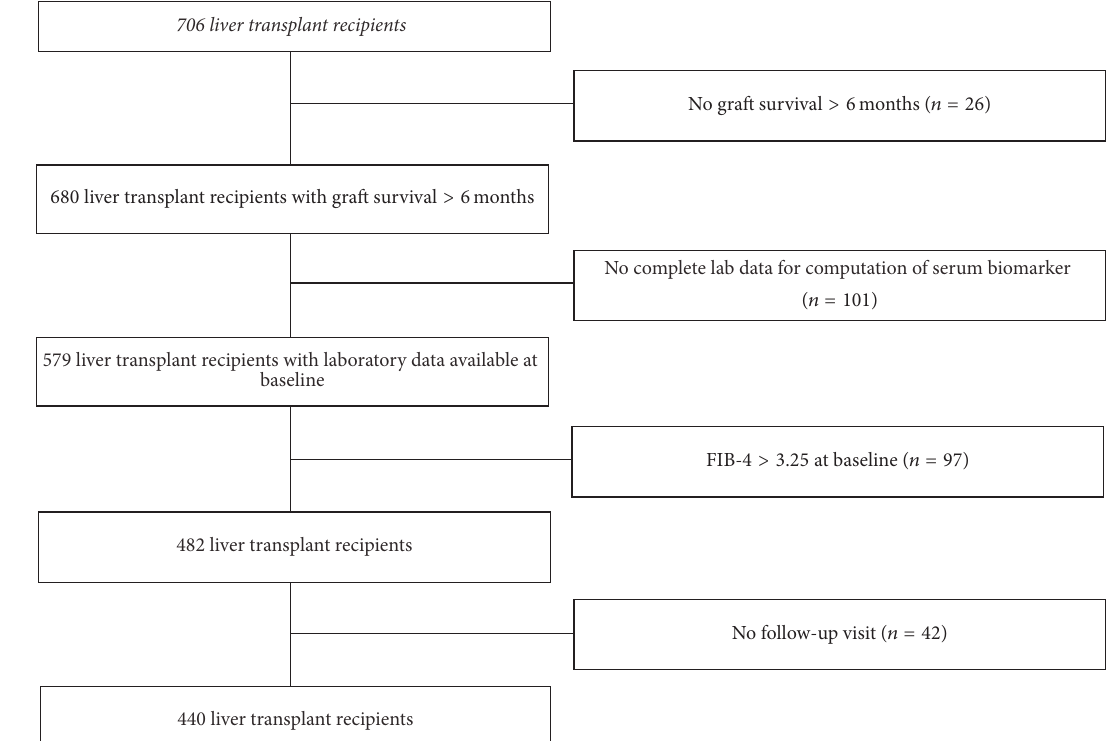
Figure 1: Flow chart displaying selection of study participants for analysis. Out of 706 liver transplant recipients present in the Solid Organ Transplant Unit database, 26 patients were excluded because of graft survival < 6 months and 101 patients were excluded because of missing data. After further exclusion of 97 patients who had the outcome at baseline and 42 cases without a follow-up visit, the remaining sample of 440 consecutive liver transplant recipients was included in the present